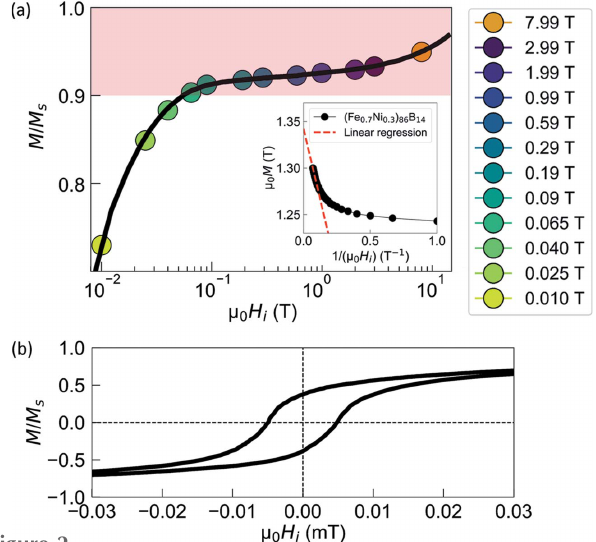
Figure 2 ( a ) Normalized positive magnetization branch measured at room temperature (semi-logarithmic scale). Color-filled circles: M / M S values for which the SANS measurements have been performed. The approach- to-saturation regime, defined as M / M S (cid:10) 90%, is indicated by the red- shaded area. Inset: plot of the magnetization as a function of 1/ H i (black circles). Red dashed line: linear regression for (cid:6) (linear–linear scale). ( b ) Normalized magnetization curve measured using a Riken Denshi BHS-40 DC hysteresis loop tracer, revealing a coercivity of (cid:6) 0 H C ’ 0.0049 mT (linear–linear